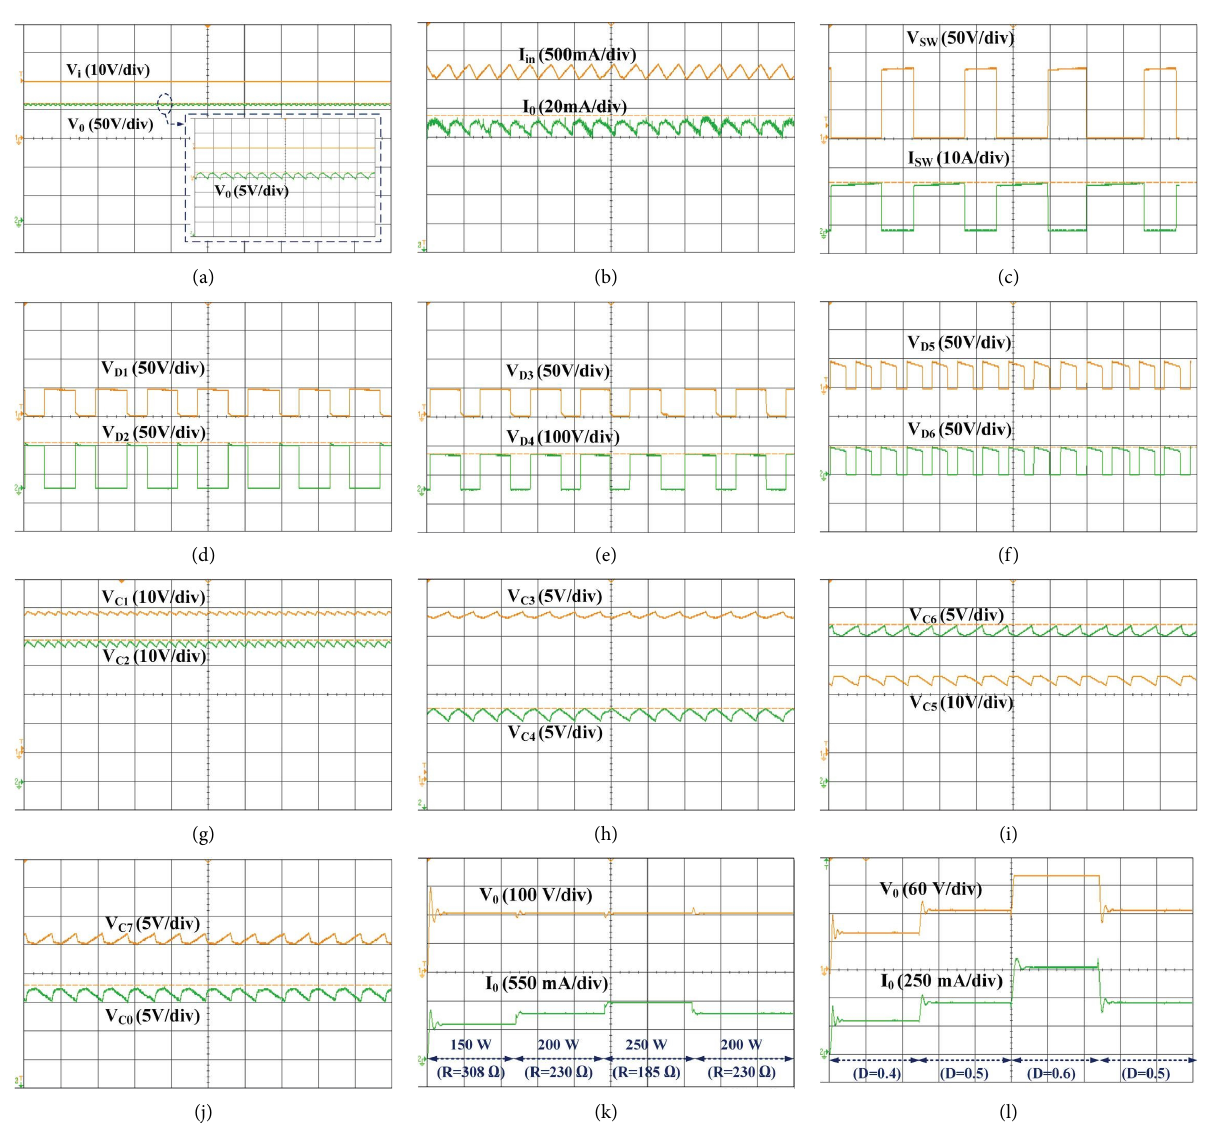
Figure 9: (a) Input and output voltage, (b) input and output current, (c) voltage and current stress on switch, voltage across diodes, (d) D and D , (e) D and D , (f) D and D , (g) voltage across capacitors C 2 3 4 5 6 and output current for the varying load, and (l) output voltage for the varying duty